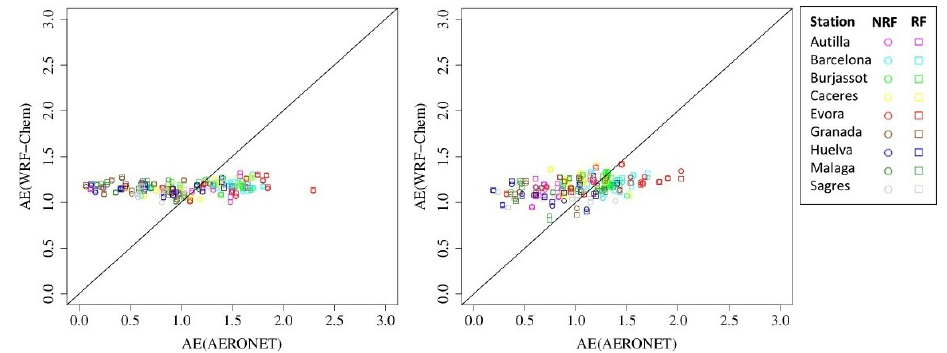
Figure 10. Linear regression between AERONET ( x ) and simulation daily data ( y , NRF in circles and RF in squares) of AE 440 / 870 : dust episode (from 28 June to 12 July, left) and fire episode (from 25 July to 7 August,